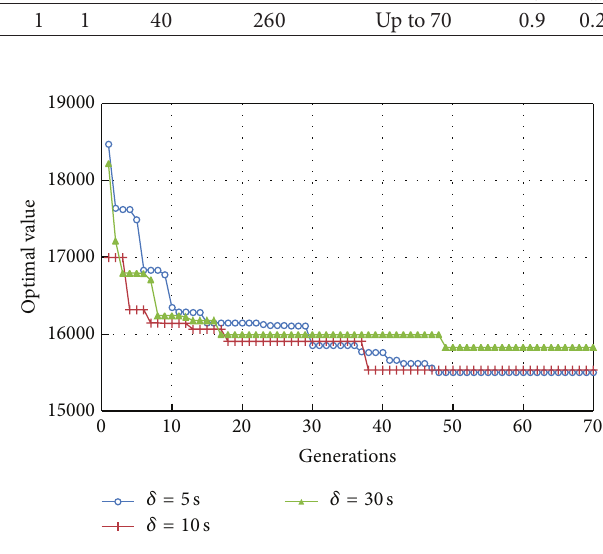
Figure 13: Optimization process of